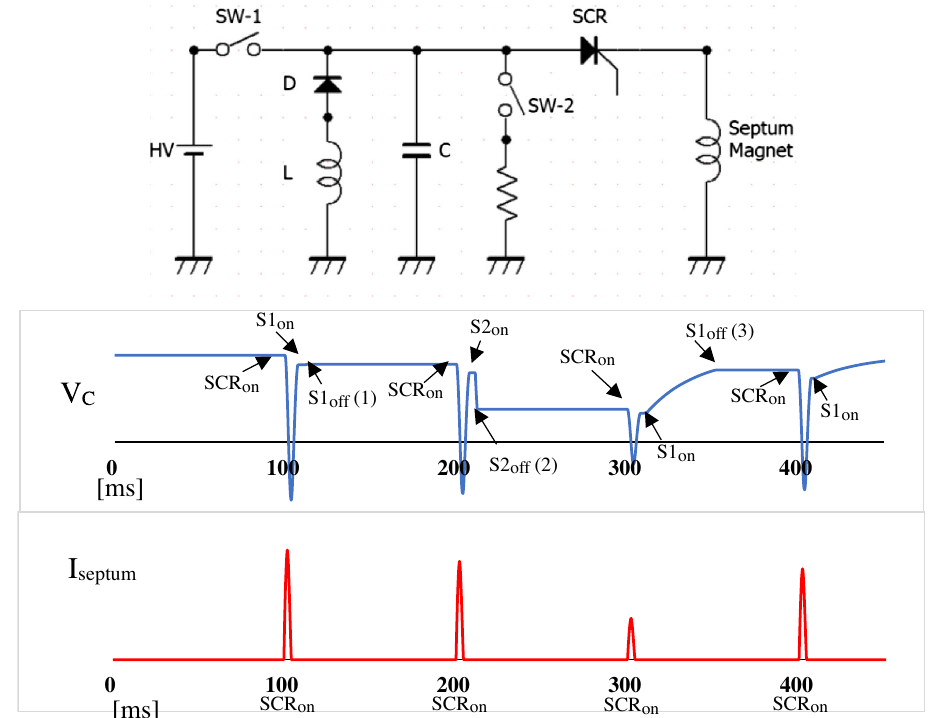
FIG. 12. Upper: circuit architecture of the septum magnet; lower: charging voltage of capacitor (C) and excitation current of septum magnet for energy-varying one-turn